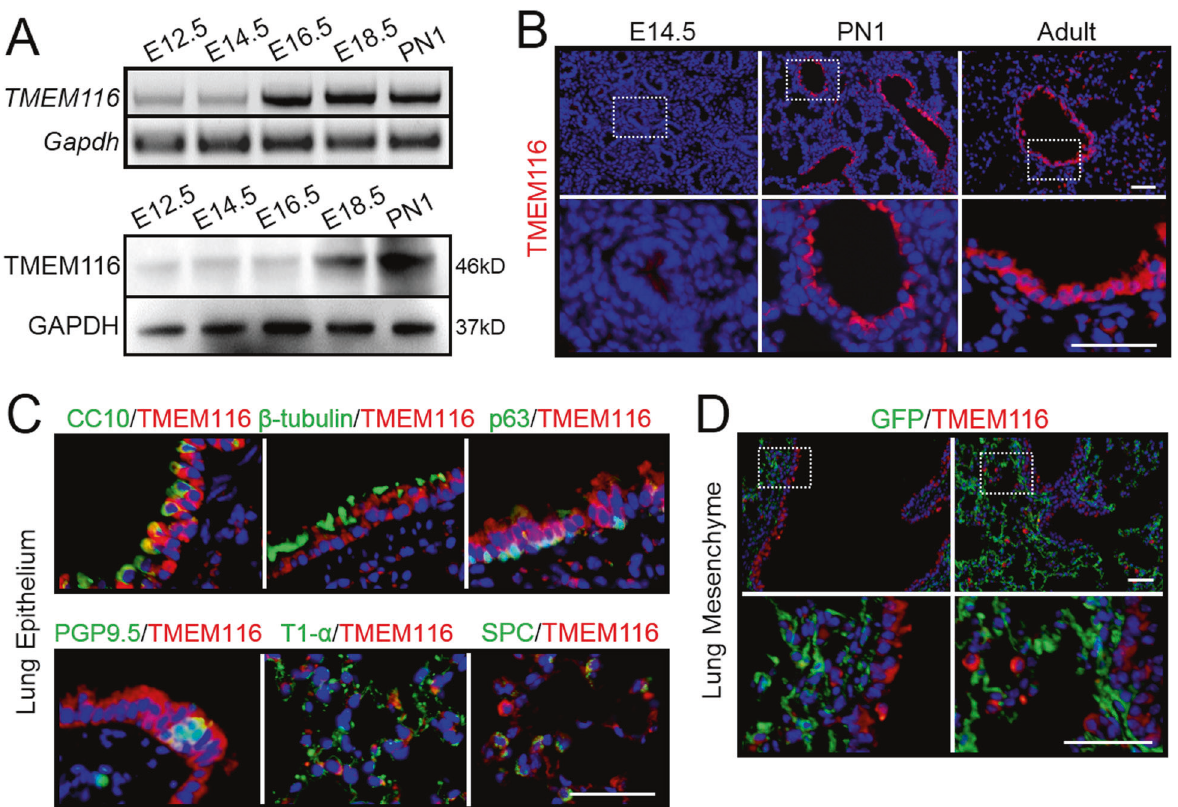
Fig. 1 The expression pattern of TMEM116 in mouse lung. A The expression level of TMEM116 in mouse embryonic lungs were examined by RT-PCR and western blot analyses. B Immuno- fl uorescence (IF) staining analysis showed TMEM116 expression in E14.5, PN1 and adult mouse lungs. C Double IF staining analysis of TMEM116 and p63, β -tubulin, CC10, PGP9.5, T1- α , and Spc respectively. D IF staining analysis of TMEM116 and GFP in Dermo1-cre; ROSA mTmG mice. Representative images from three independent experiments are shown above. Scale bar: 50 μ